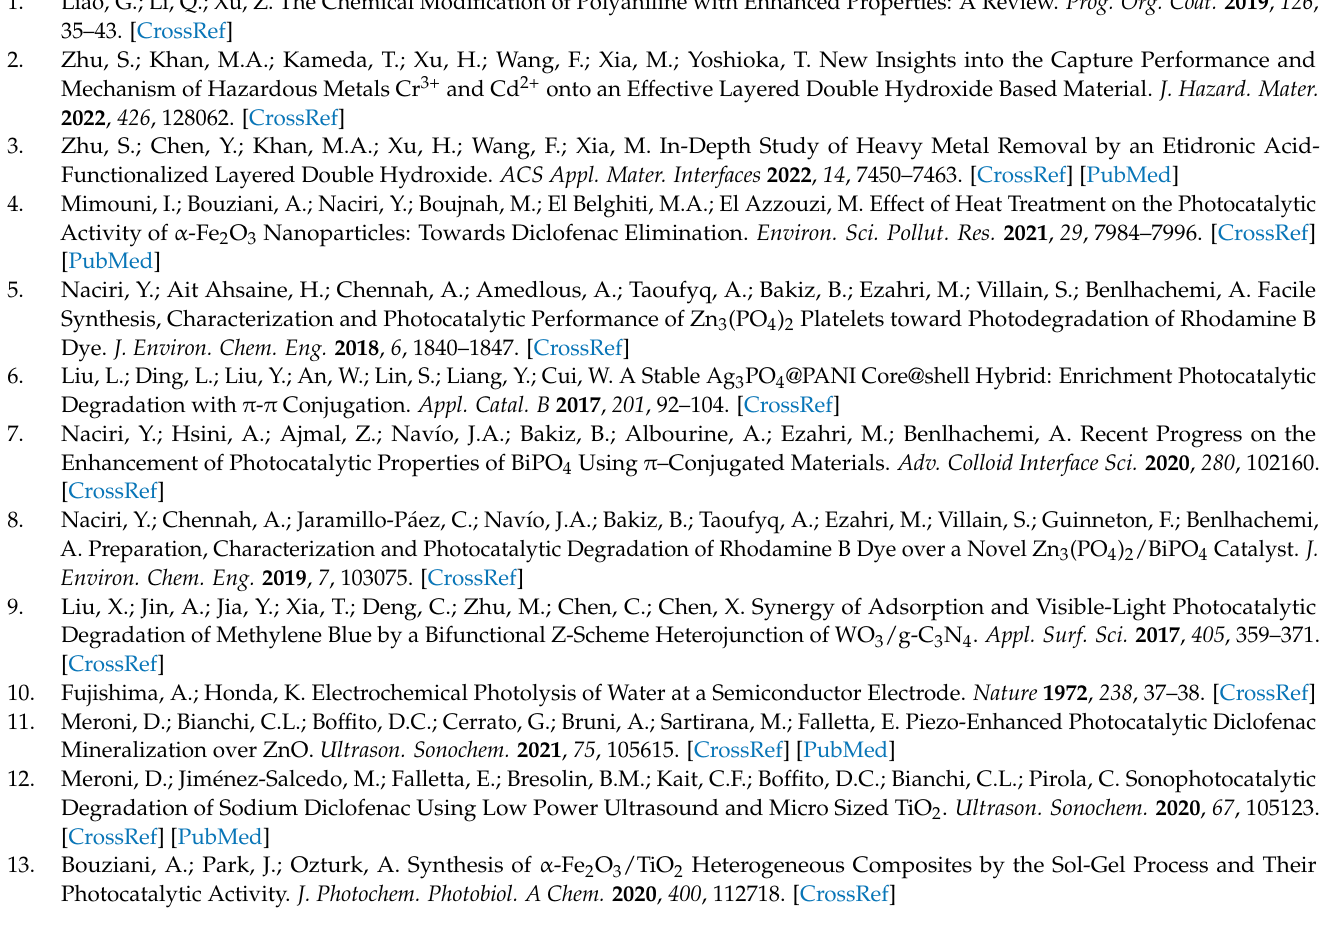
Figure S7. UV-visible spectra of Bi 2 O 3 ; Figure S8. Conversion plots for the photodegradation of MB by PANI, Bi 2 O 3 , blank and in Dark; Figure S9. Kinetic curves (ln(C/C 0 ) = f(t)) of MB